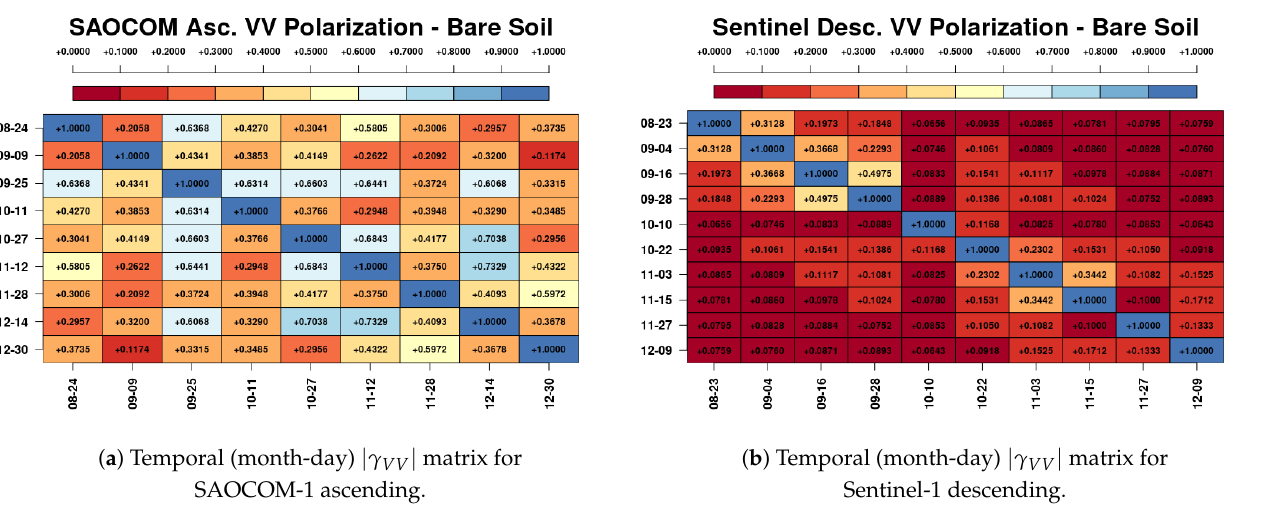
Figure 6. Bare-soil area , Corrientes